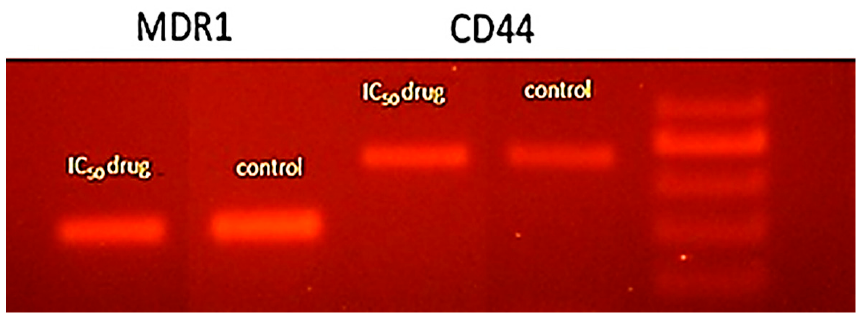
Figure 8. The fragmentation analysis of DNA under the effect of M. longipetala extract. MDR1 and CD44 antibody pathways were characterized as targets of M. longipetala -dependent apoptosis.